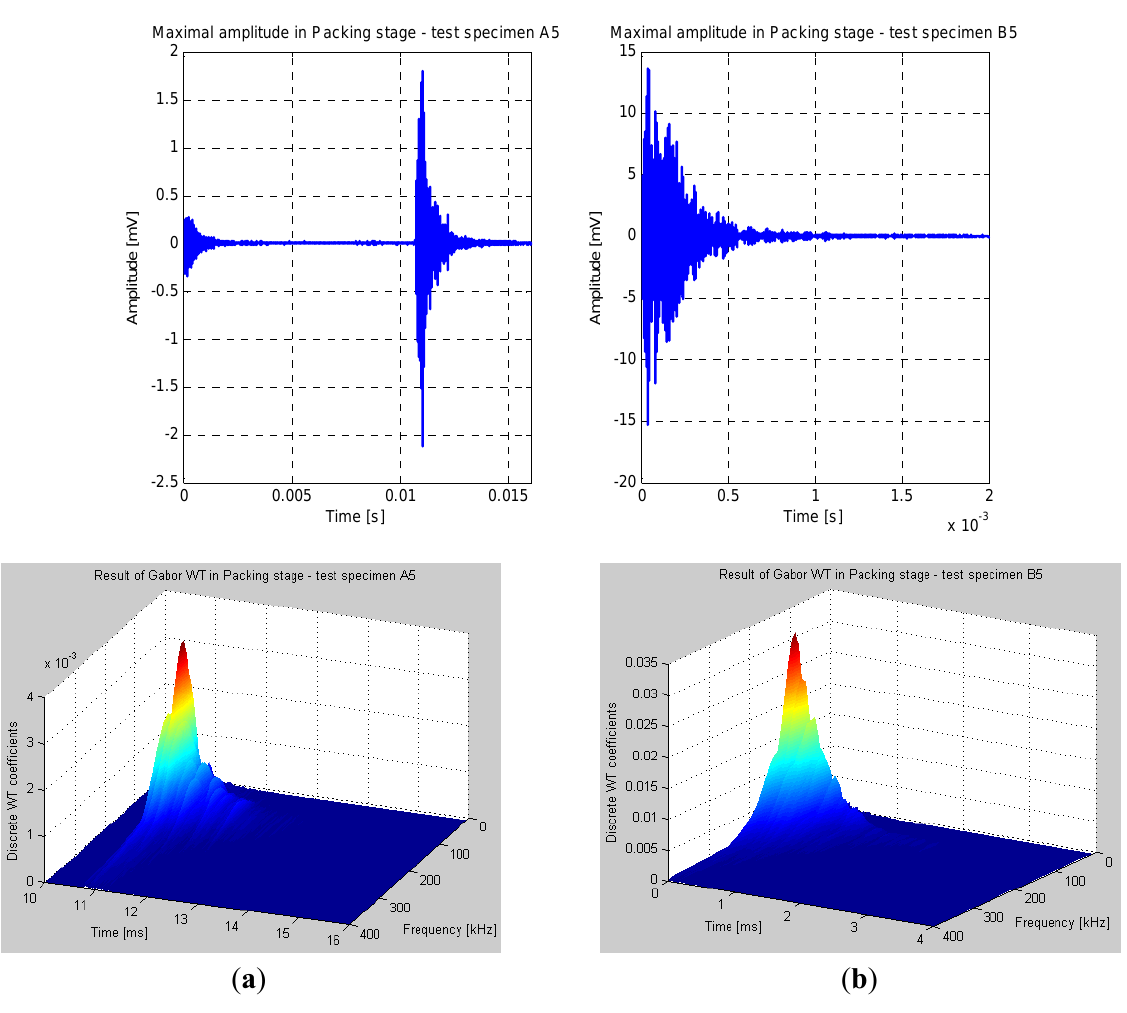
Figure 7. Maximal amplitudes and Gabor wavelet result during the packing stage. ( a ) Test specimen A5 (new engraving insert); ( b ) Test specimen B5 (used engraving insert with